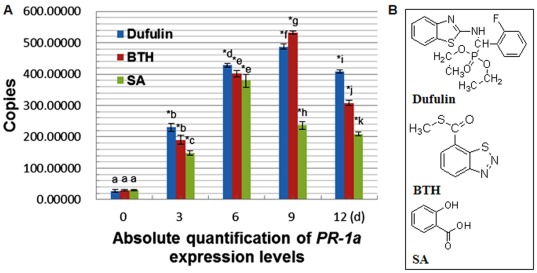

PR-1a gene expression analysis by qPCR.(A) Quantitative real-time PCR was performed using gene-specific primers (listed in Table 5) and the SYBR Green Realtime Master Mix. Expression ratios of the PR-1a gene in plants treated with BTH, Dufulin and exogenous SA at 500 µg/mL at 0, 3, 6, 9 and 12 days. Asterisks indicate statistically significant difference (P<0.05). The different lowercase letters indicate PR-1a expression values that are significantly different between the different treatment groups at the same treatment time at P<0.05. (B) Molecular structures of Dufulin, BTH and SA.